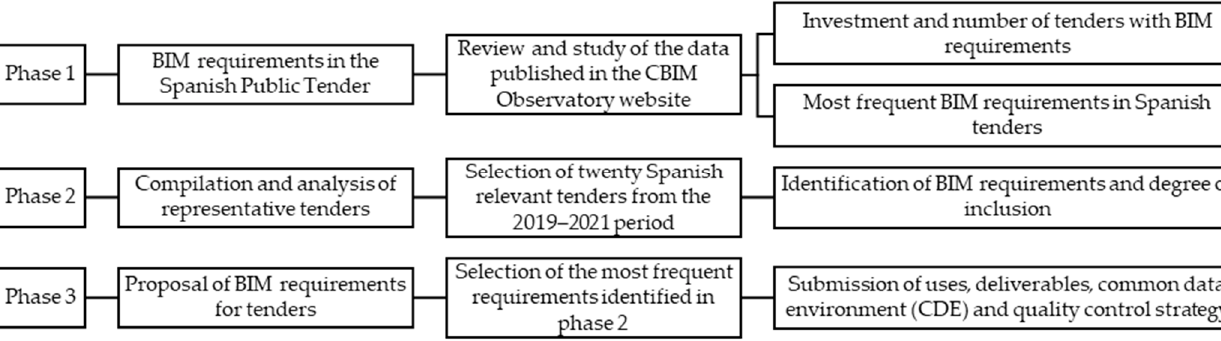
Figure 2. Phases of the applied methodology.